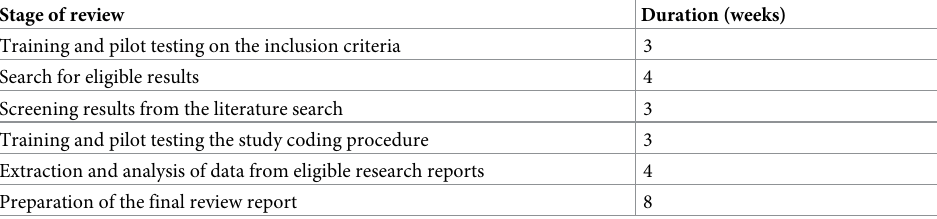
Table 4. Estimated duration required for each stage of the systematic